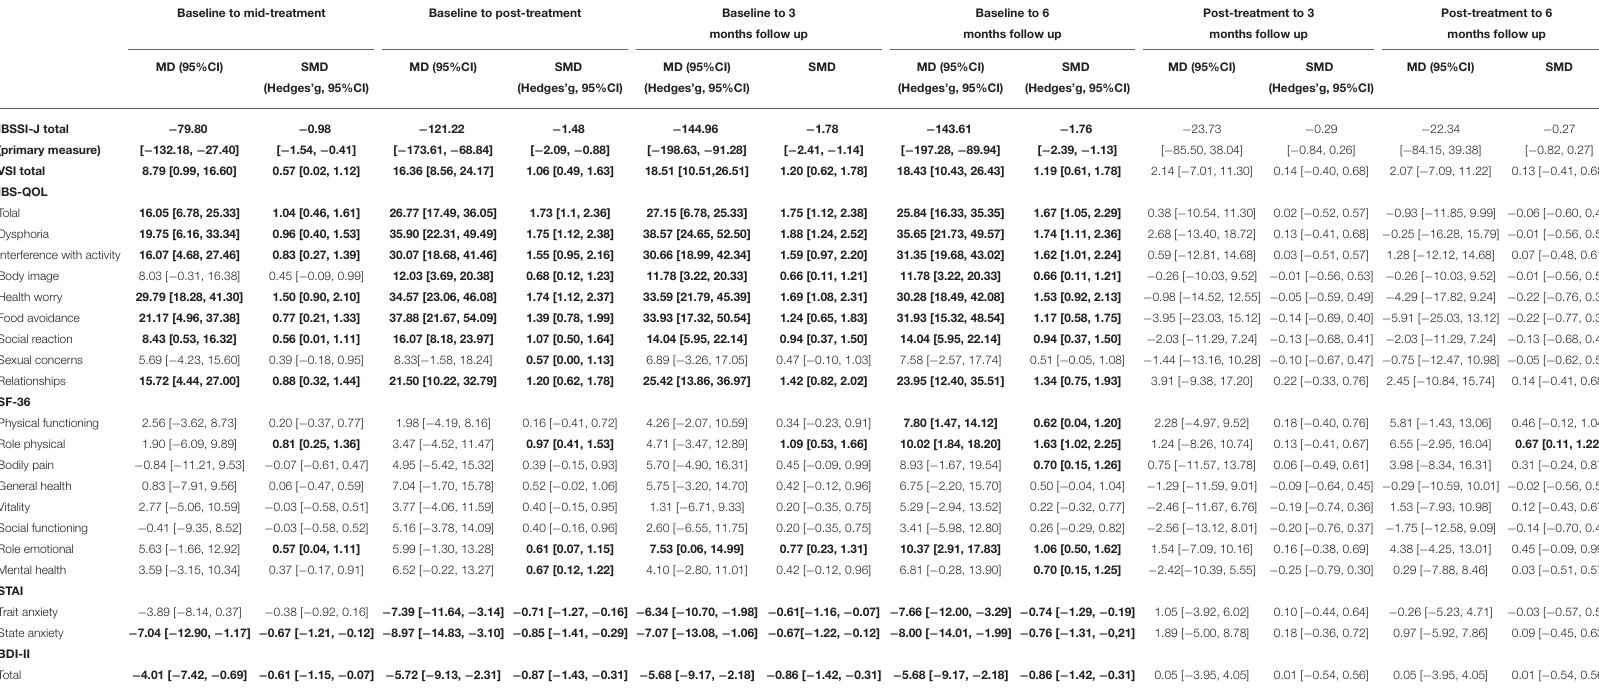
LMM, Linear mixed model; MD, Mean difference; SMD, Standardized mean difference (Hedge’s g); IBSSI, Irritable Bowel Syndrome Severity Index; VSI, Vischeral Sensitivity Index; IBS-QOL, Irritable Bowel Syndrome-Quality Of Life. Bold values indicate statistically significant mean differences based on a P < 0.05 level and their 95% confidence